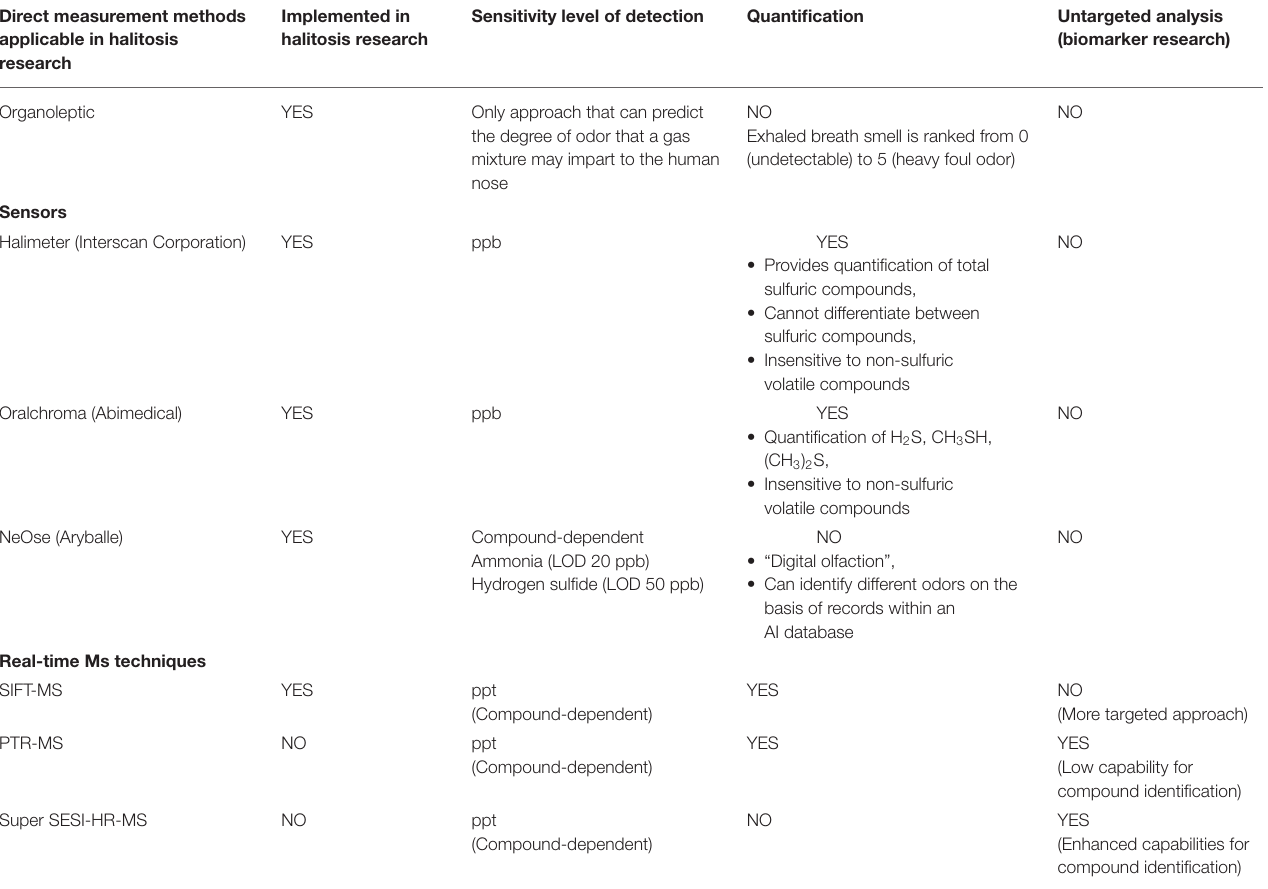
TABLE 2 | Comparison of direct exhaled breath measurement methods applicable in halitosis